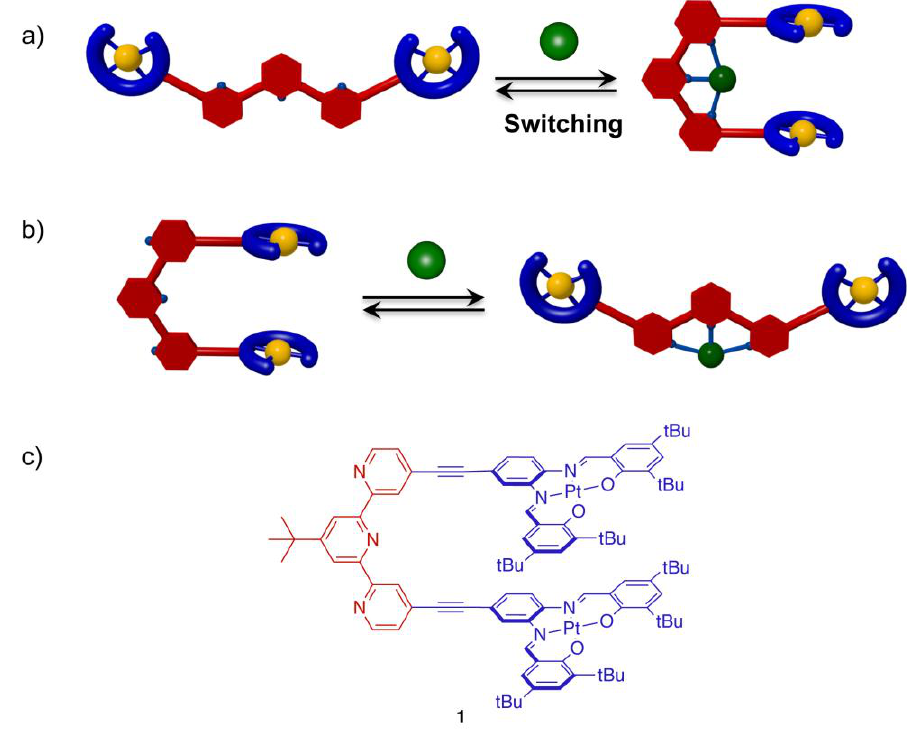
Figure 1. Schematic representation of the: a ) previous and b ) new switchable molecular tweezers; c ) molecular structure of synthetized tweezers.